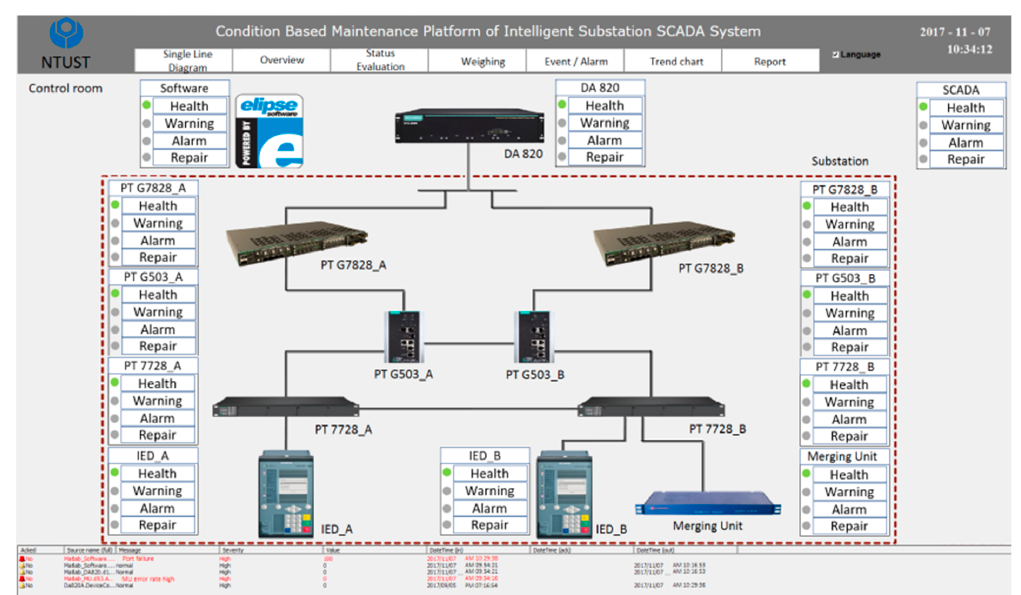
Figure 5. The CBM platform of the intelligent substation SCADA system.